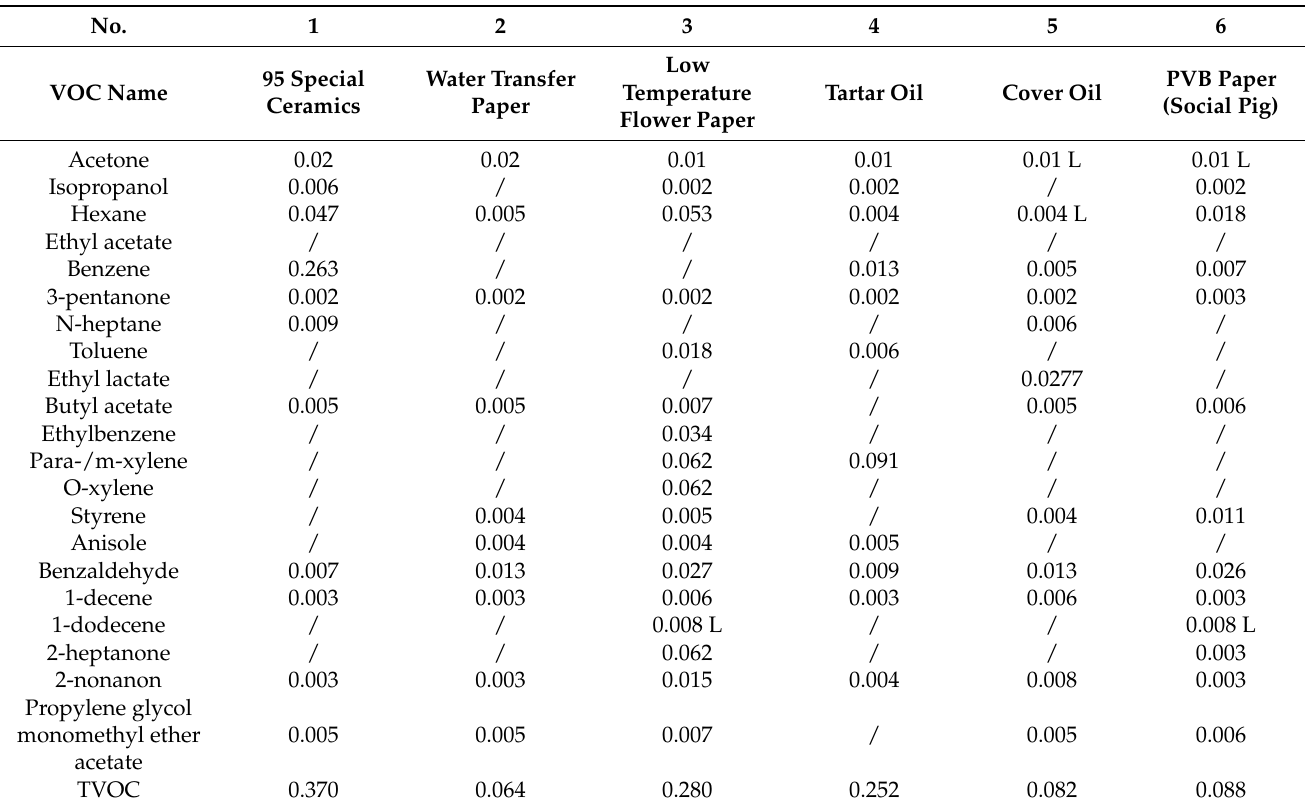
Table 5. VOC analysis results in sample flue gas (mg · m − 3 ).